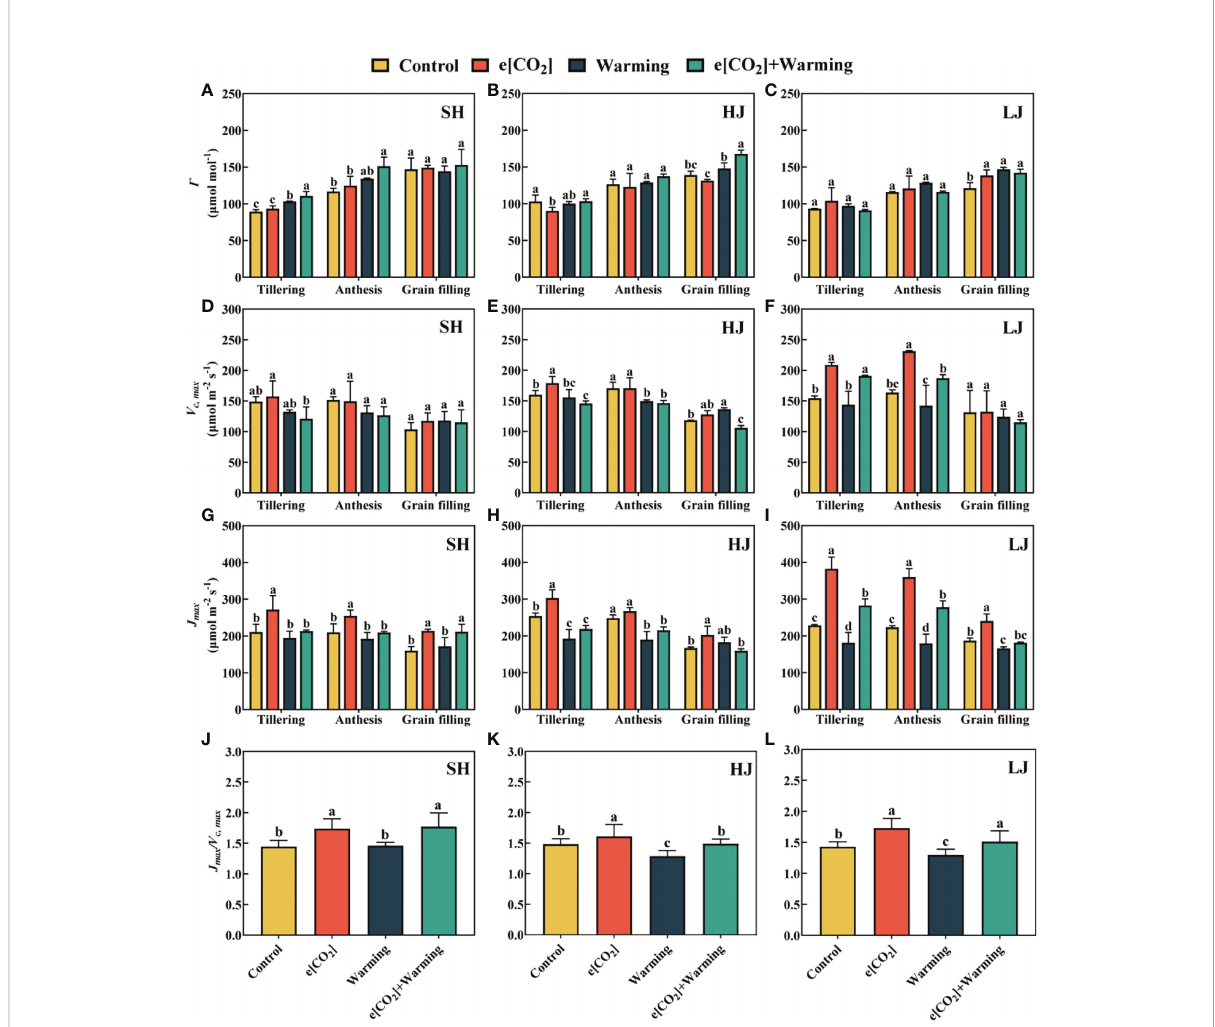
FIGURE 5 Model parameters were determined from A n - C i data. Carbon dioxide compensation point ( G , A – C ), maximum ribulose-1, 5-bisphosphate carboxylase/oxygenase (Rubisco) carboxylation rate ( V c, max , D – F ), and potential light saturated electron transport rate ( J max , G – I ) under e[CO 2 ] and warming at the tillering, anthesis, and grain- fi lling stages of SH (Shishoubaimao), HJ (Hejiang 19), and LJ (Longjing 31). Data are means ± standard errors (n = 3). The data of ( J max / V c, max , J – L ) radio is the average means ± standard errors (n = 9) at three stages in each cultivar. Different letters indicate signi fi cant differences between mean values at P < 0.05